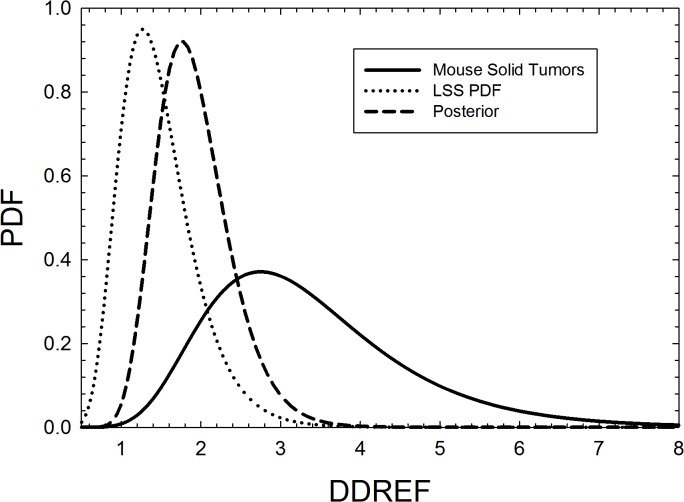
Bayesian analysis of the probability distribution function (PDF) representing the uncertainty in the dose and dose-rate reduction effectiveness (DDREF) parameter.The prior distribution is based on the BEIR VII report analysis of the Japanese survivor solid cancer data [30], the likelihood function uses the log-normal function to represent DDREFs for the mouse solid tumor data in Table 2, and the posterior distribution the prediction using Bayes theorem.